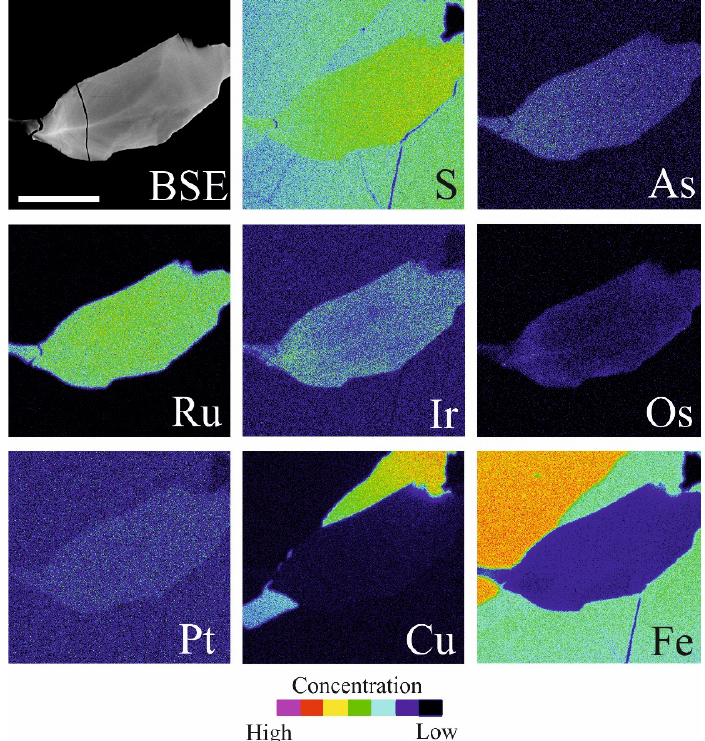
8 of 12 Figure 5. ( A ) BSE image of a Pb-Cl mineral (Pb-Cl) enclosed in pyrrhotite (Po), scale bar = 10 µm, and ( B ) its EDS spectrum (see the text for the Pb-S overlap). 5. Origin of the Zoned Laurite in the Merensky Reef Several theories for the origin of the Merensky Reef have been proposed, and they have been recently summarized by [25]. The proposed genetic models include: i) gravitational settling of